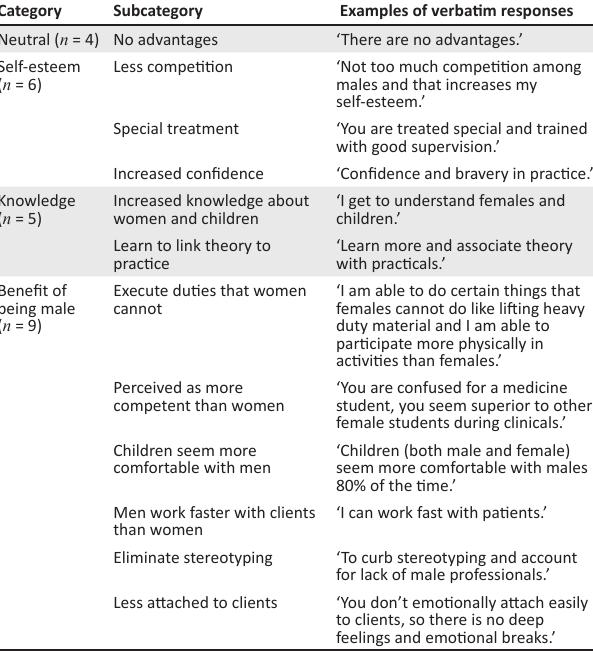
TABLE 5: Advantages of being male in a female-orientated training programme ( n = 24).